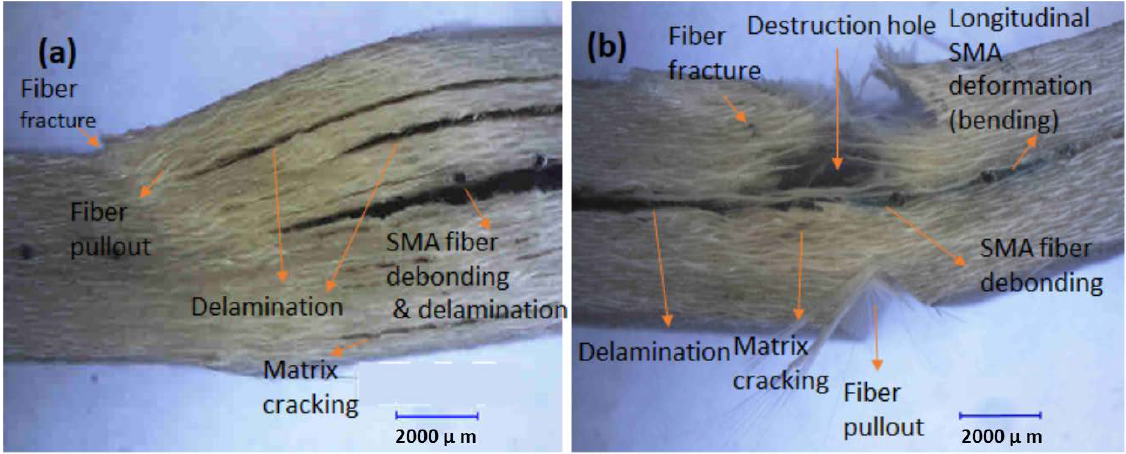
Figure 16. ( a ) Unnotched SMA/GFRP; ( b ) notched SMA/GFRP.